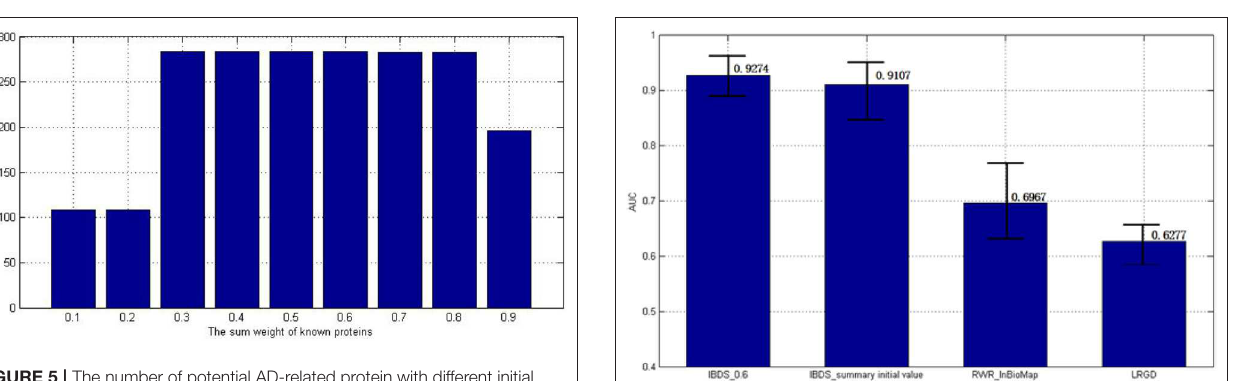
FIGURE 5 | The number of potential AD-related protein with different initial values.